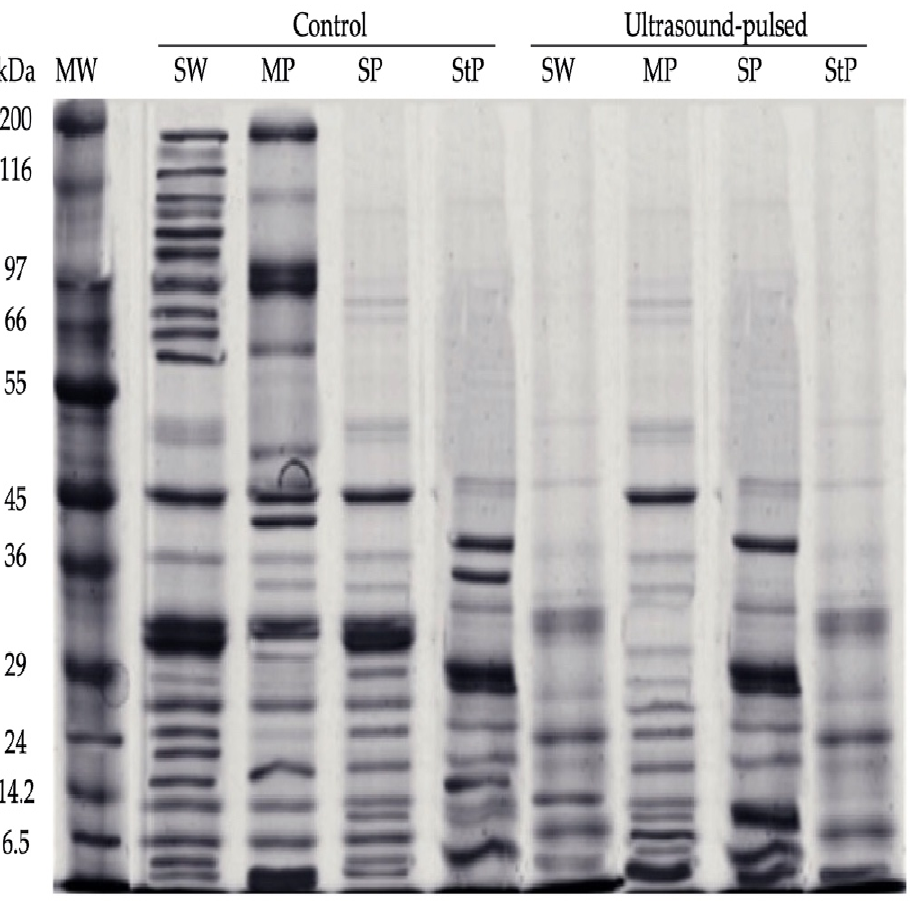
Figure 2. Protein patterns of anchoveta stickwater with and without ultrasonic pulses. MW, molecular weight standard; SW, stickwater; MP, myofibrillar protein; SP, sarcoplasmic protein; StP, stromal protein.